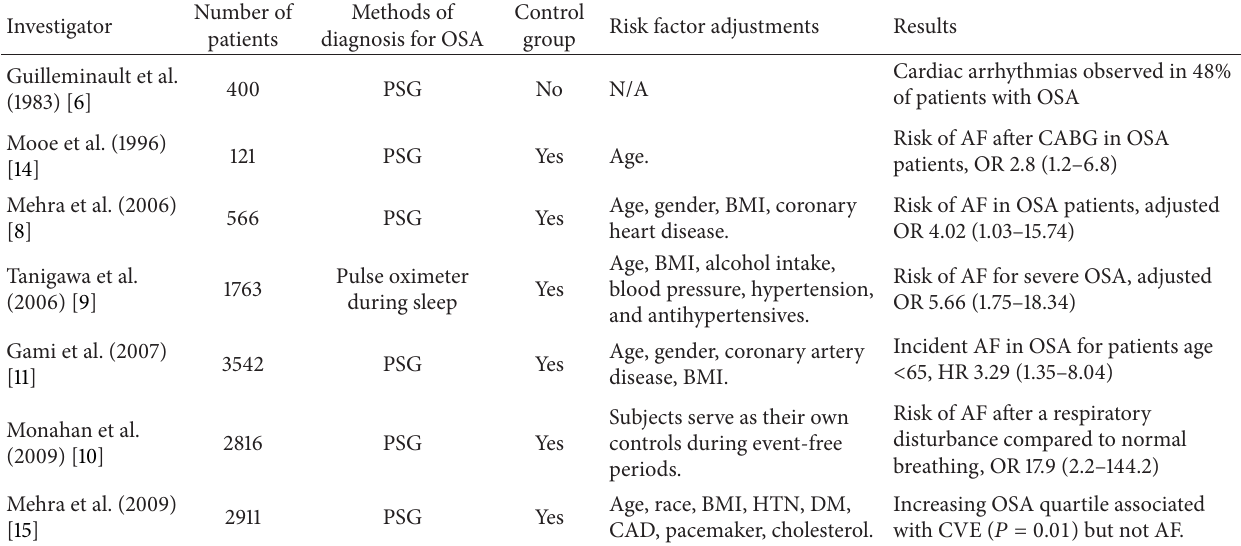
Table 1: Risk of AF in OSA